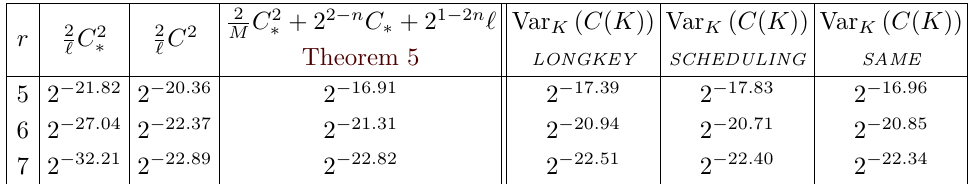
Table 3: Comparison of between different theoretical and experimental capacity